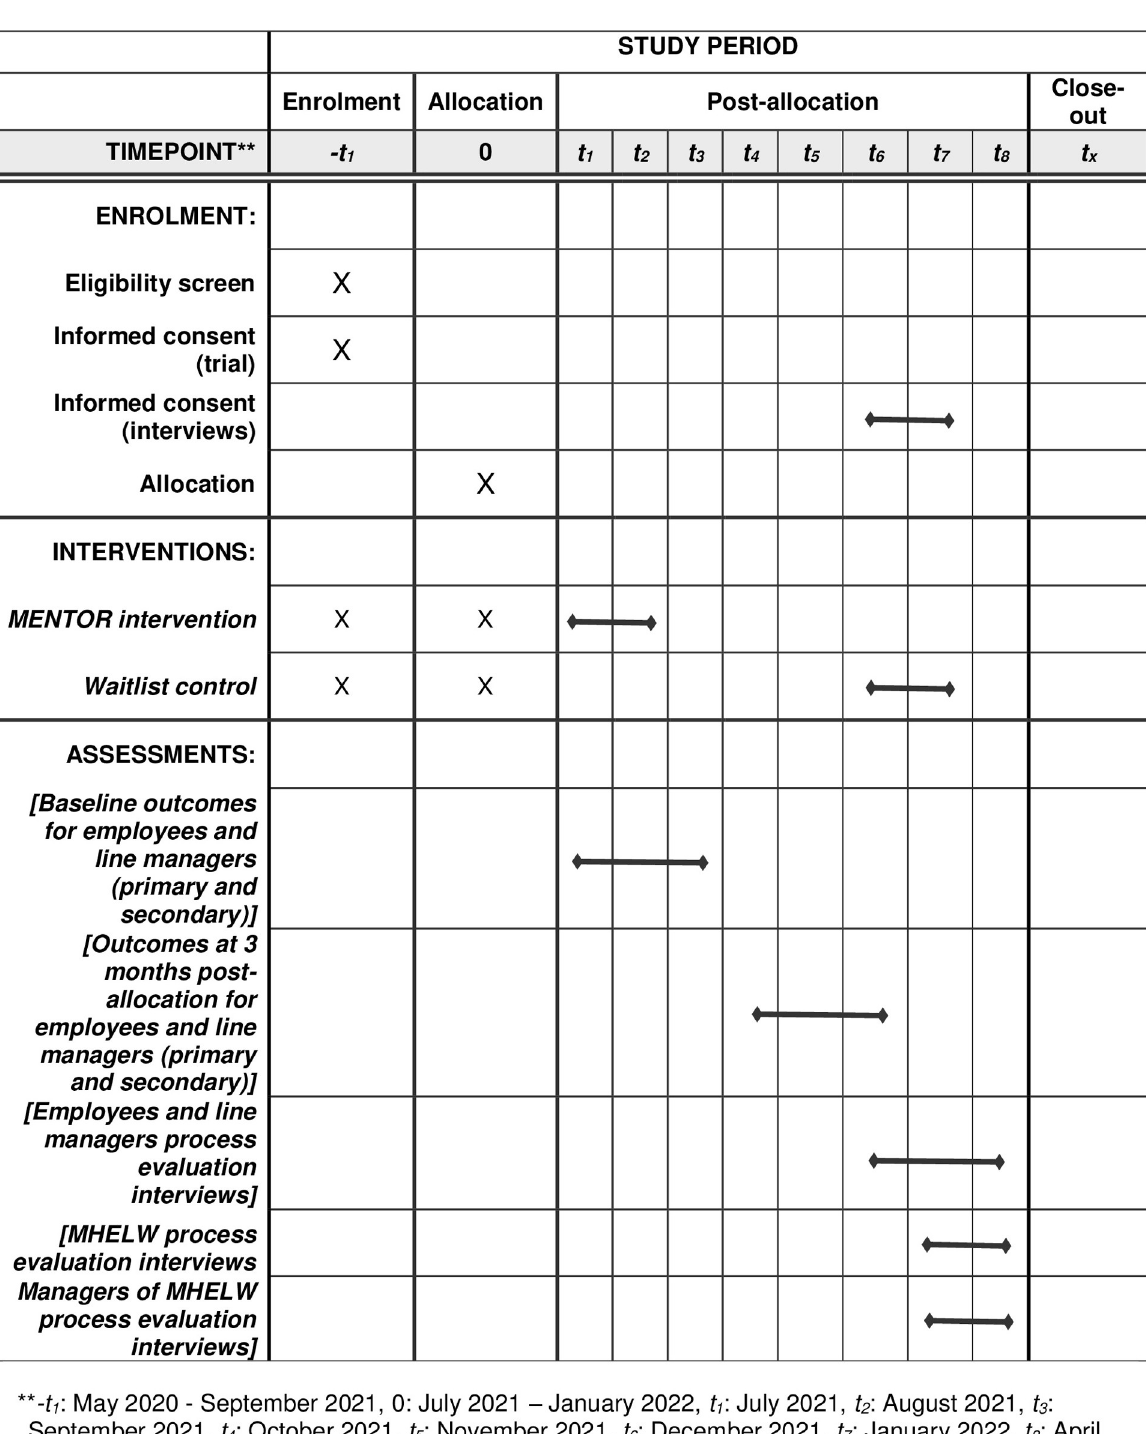
PLOS ONE | https://doi.org/10.1371/journal.pone.0283598 April 20, 2023 4 /